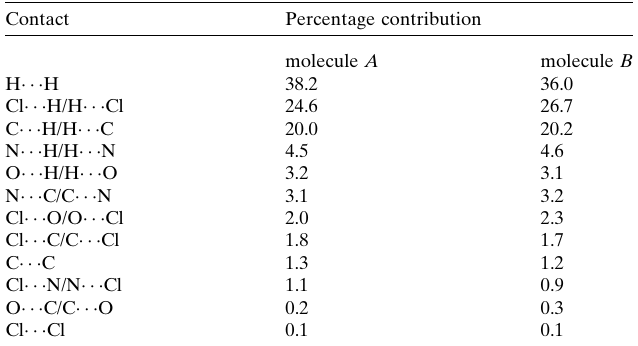
Table 3 Percentage contributions of interatomic contacts to the Hirshfeld surfaces for the molecules A and B of the title compound in the asymmetric unit.